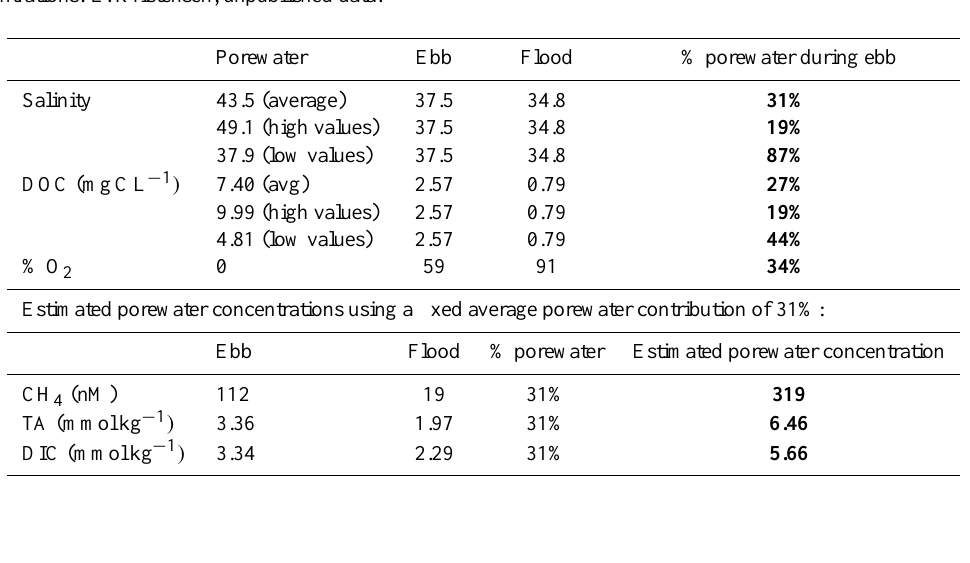
Figure 5 600 Fig. 5. Tidal variations of water height and (a) CH 4 concentrations and pCO 2 , (b) total alkalinity and dissolved inorganic carbon con- centrations, (c) δ 13 C signatures of dissolved inorganic carbon, and (d) dissolved oxygen saturation levels (%O 2 ) . Error bars on the CH 4 concentrations are 1s.d., based on triplicate measurements. Table 1. Estimated porewater contributions to the creek water column at low tide, based on salinity, DOC, and %O 2 data on porewaters at different points along the creek and in creek waters during high tide and low tide, and (lower part) calculated porewater CH 4 , TA and DIC based on an average estimated porewater contribution of 31%. Porewaters were assumed to be anoxic (i.e. %O 2 =0), porewater salinity data and DOC concentrations: E. Kristensen, unpublished